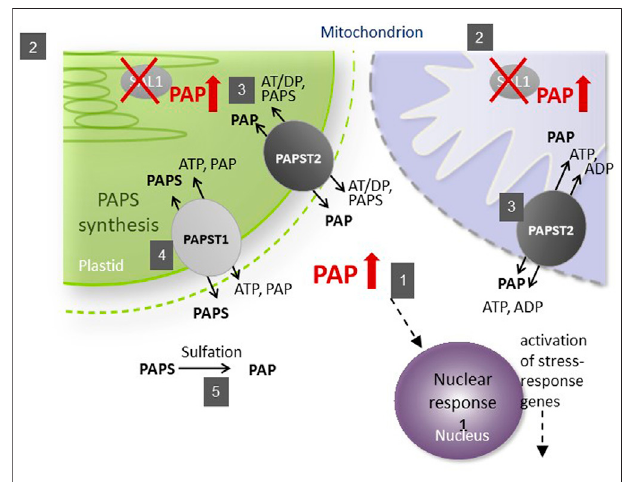
FIGURE 1 | Schematic illustration of phosphoadenosine 5 ′ -phosphate (PAP) catabolisminthe sal1 mutant.The SAL1( 2 ) protein islocalized toplastids and the mitochondria, where it regulates the intercellular PAP concentration ( 1 ). PAPST2 ( 3 ) and PAPST1 ( 4 ) import cytosolic PAP into the mitochondria and plastids. PAPST1 ( 4 ) delivers newly synthesized PAPS from the plastid to the cytosol in exchange for PAP. In the cytosol and the Golgi apparatus, PAPS consumption via sulfotransferases results in PAP release ( 5 ). A defect in SAL1 activity leads to PAP accumulation in these organelles, which decelerates PAP uptake. The resulting increase in cytosolic PAP induces nuclear responses and phenotypes recorded previously for sal1